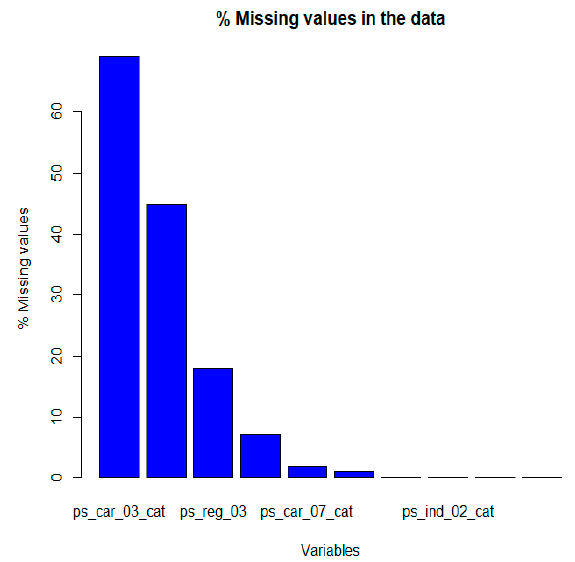
Figure 8. Missing values in our data.